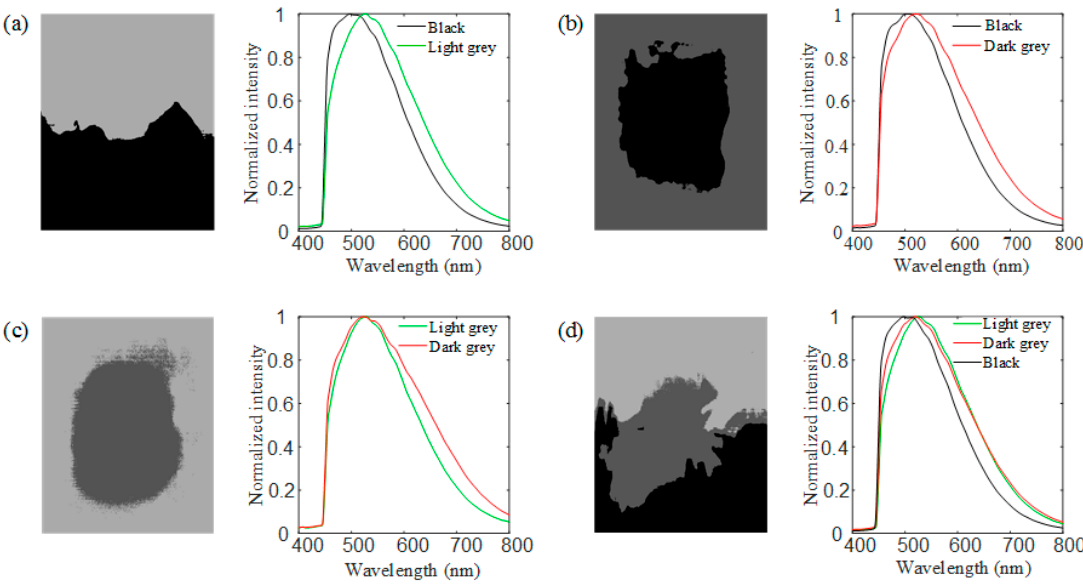
Figure 5. Imaging (pseudo color) of the spatial distribution of crude oils in four mixed samples and the average spectra of the different regions for ( a ) a mixed sample of Crude Oil 1 and Crude Oil 2; ( b ) a mixed sample of Crude Oil 1 and Crude Oil 3; ( c ) a mixed sample of Crude Oil 2 and Crude Oil 3; and ( d ) a mixed sample of Crude Oil 1, Crude Oil 2, and Crude Oil 3.